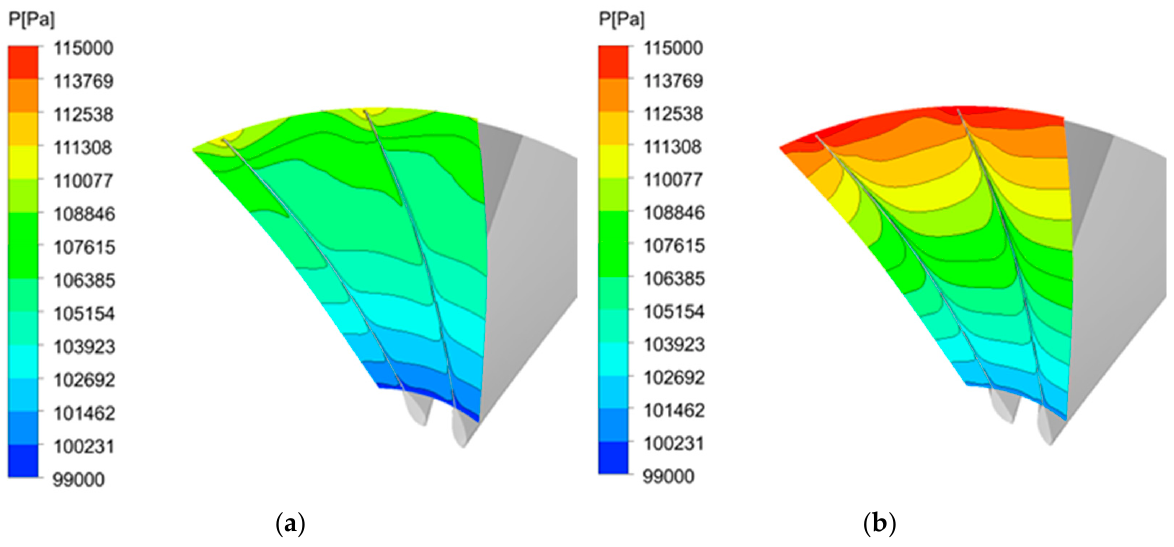
Figure 12. Static pressure contours at outlet before ( a ) and after ( b ) optimization.